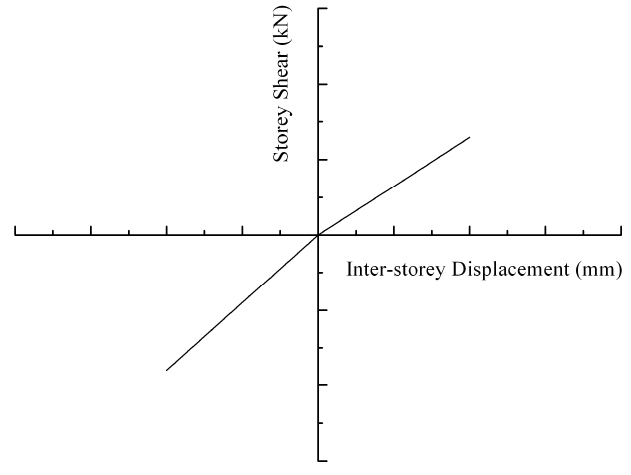
Figure 6. Restoring force model of numerical substructure.